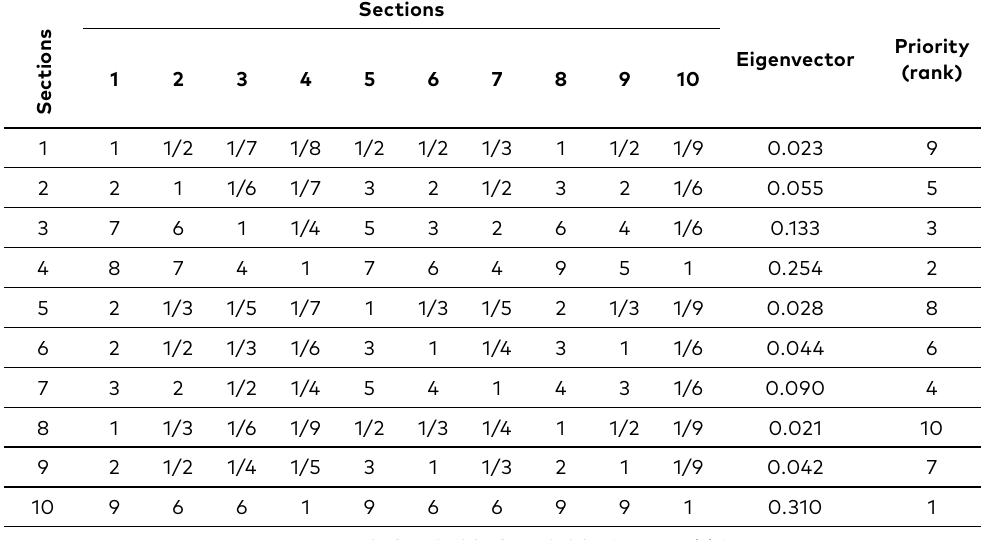
Table 10. Pairwise comparison of the accident sections